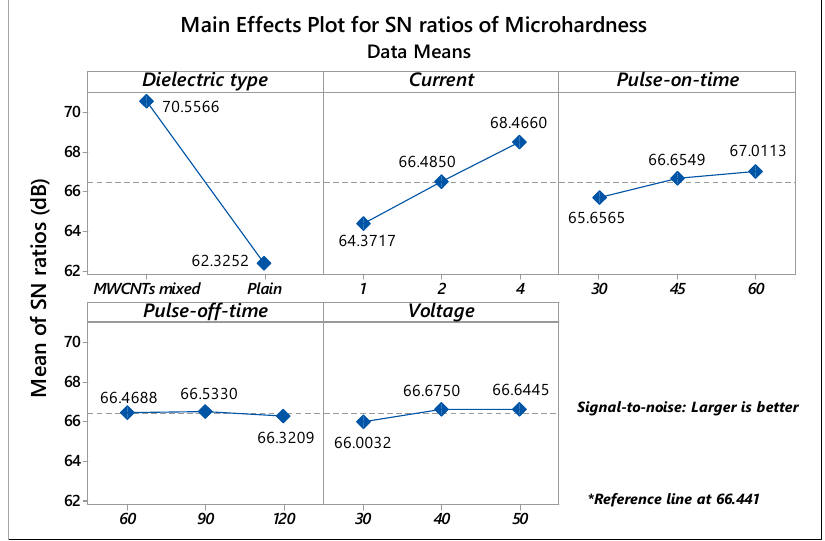
Figure 2. Main effects SN ratios plot of Microhardness. Figure 2. Main e ff ects SN ratios plot of